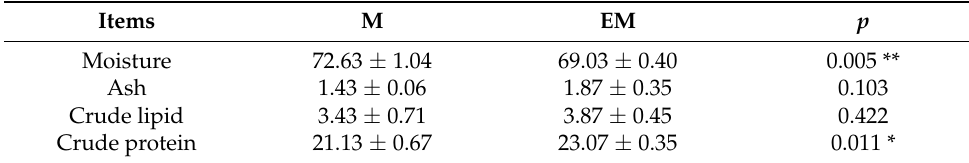
Table 3. Proximate chemical composition of fish meat (%, n =